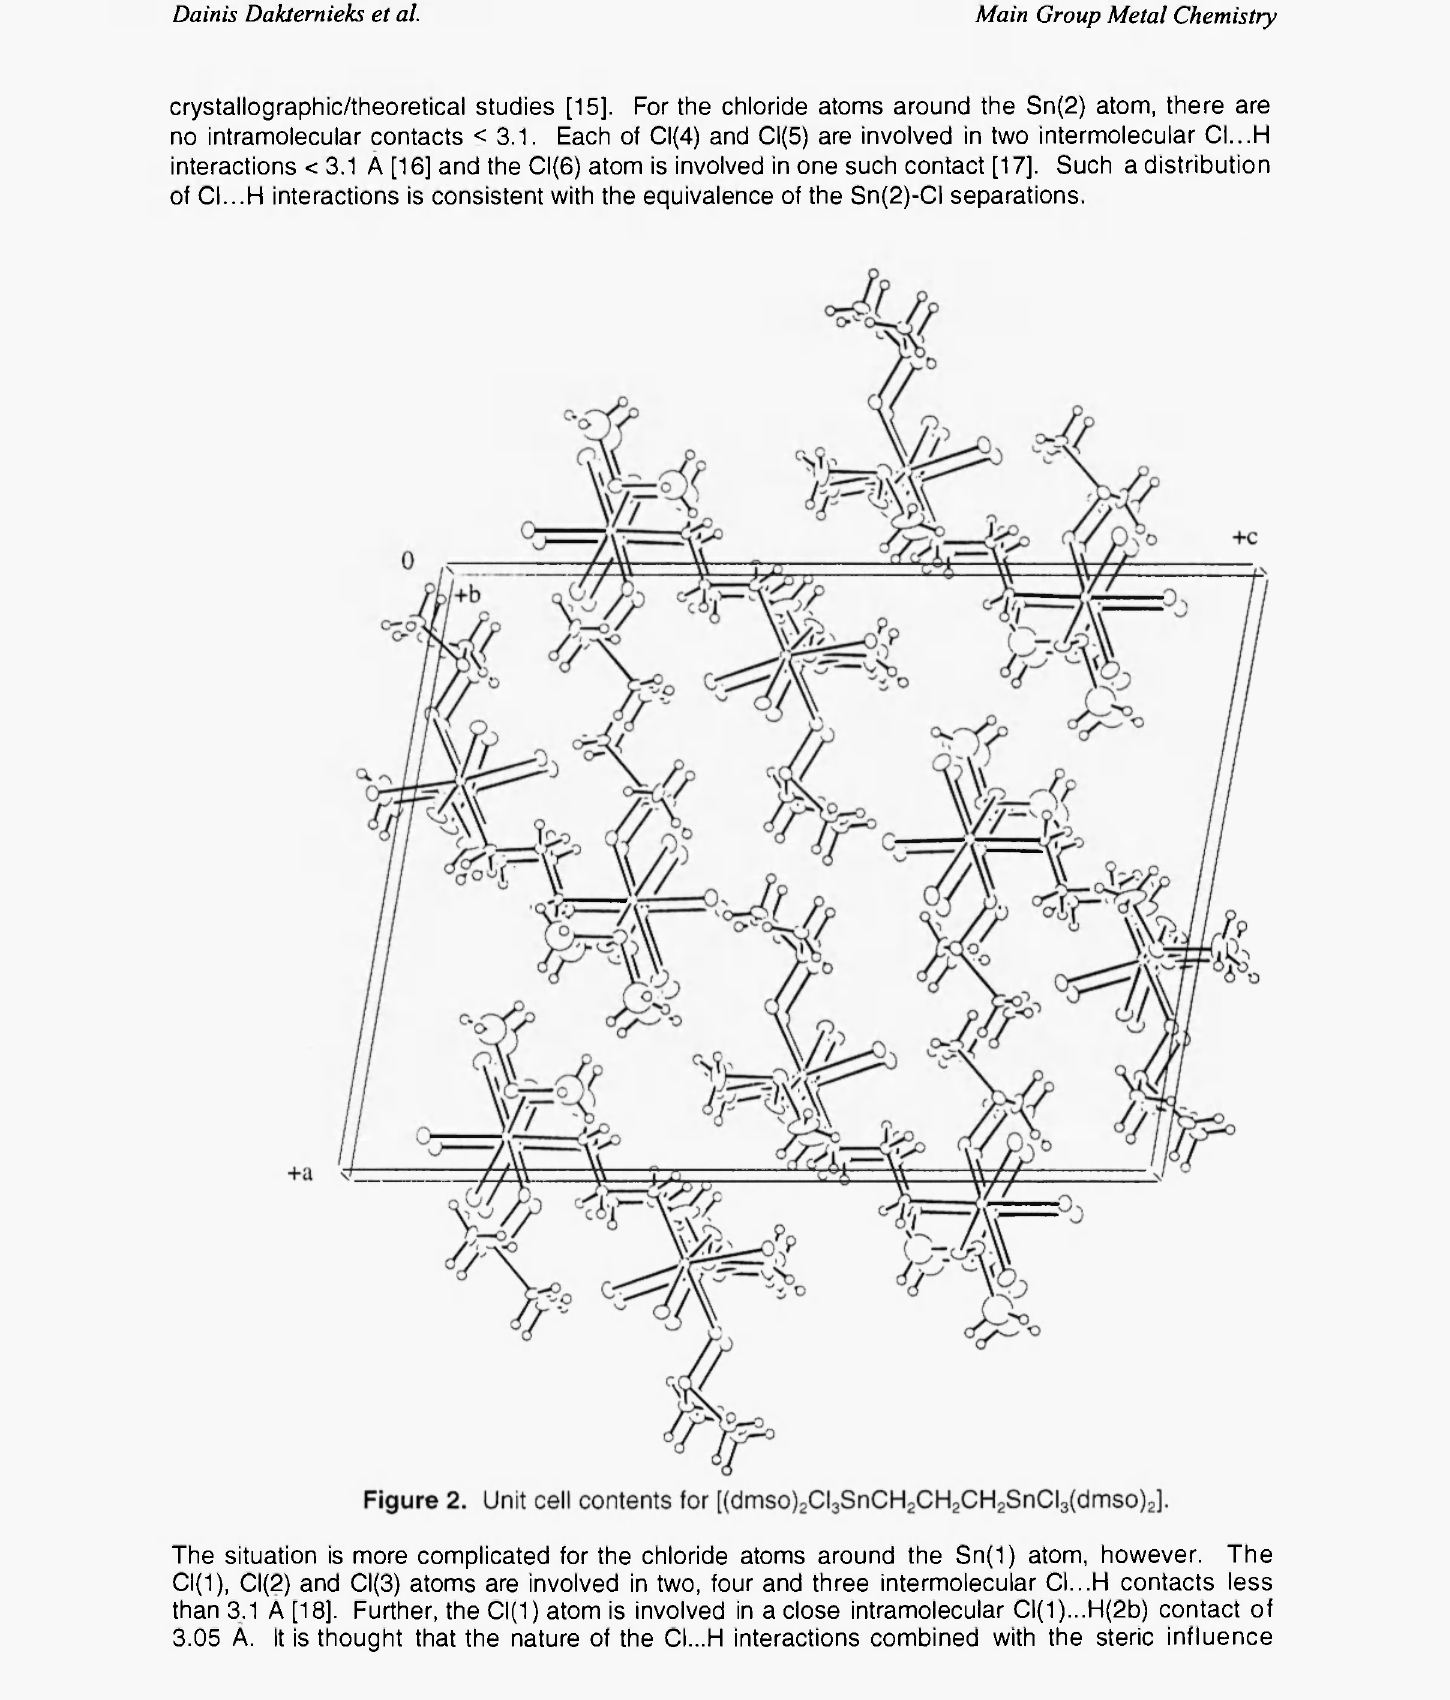
crystallographic/theoretical studies [15]. For the chloride atoms around the Sn(2) atom, there are no intramolecular contacts < 3.1. Each of Cl(4) and Cl(5) are involved in two intermolecular